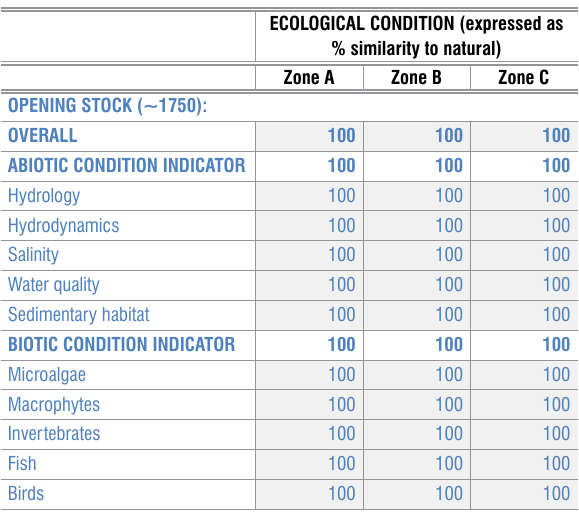
Table 5: Ecosystem condition account for the Swartkops Estuary based on selected abiotic and biotic indicators (derived from Van Niekerk et al. and Adams et al. 23,24 ) ECOLOGICAL CONDITION (expressed as % similarity to natural) Zone A Zone B Zone